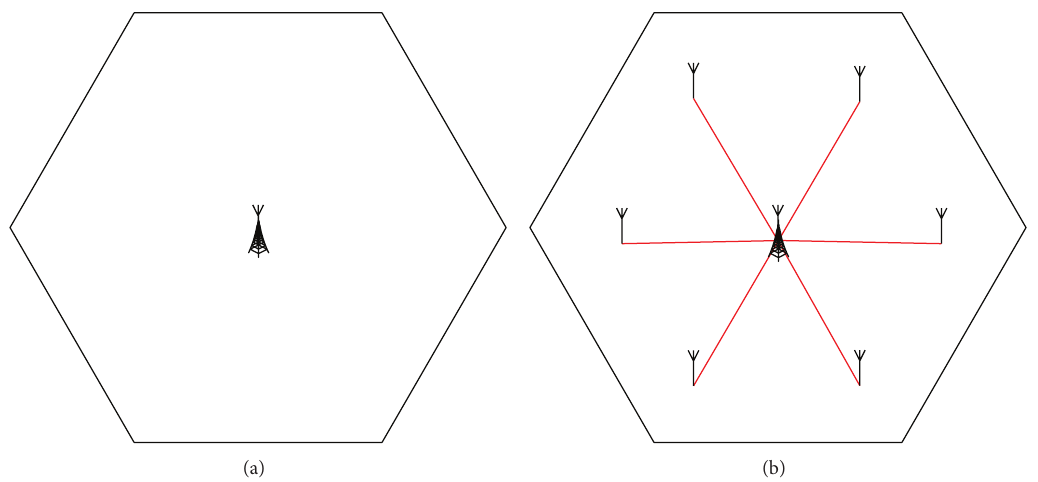
Figure 2: Deployment scenarios: (a) BS only; (b) DAS with one BS and six